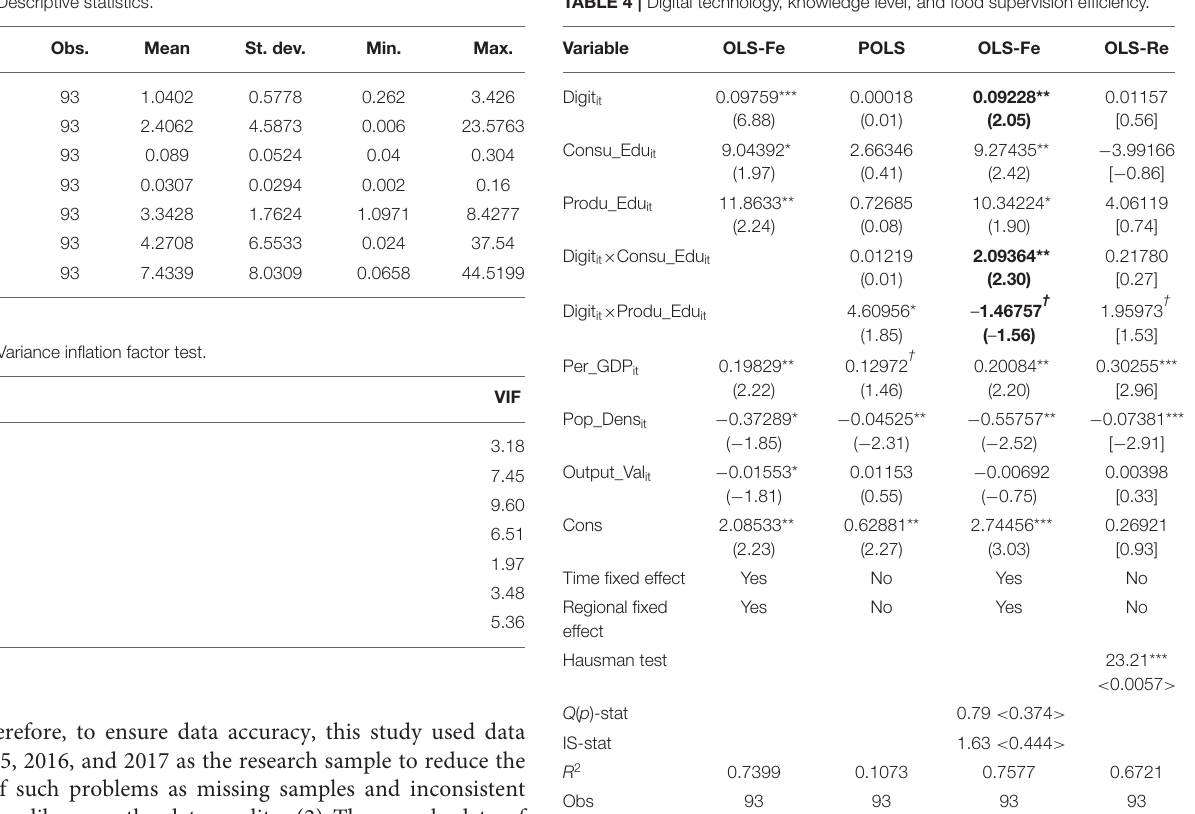
TABLE 4 | Digital technology, knowledge level, and food supervision